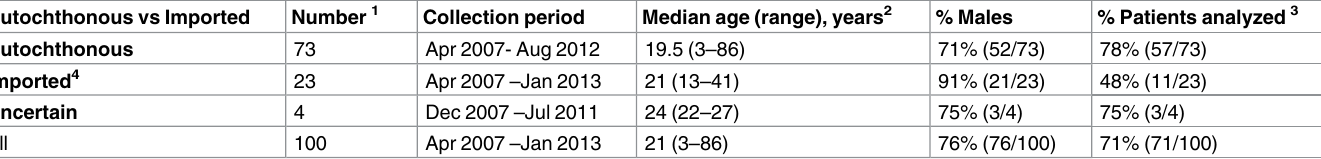
Table 1. Patient sampling